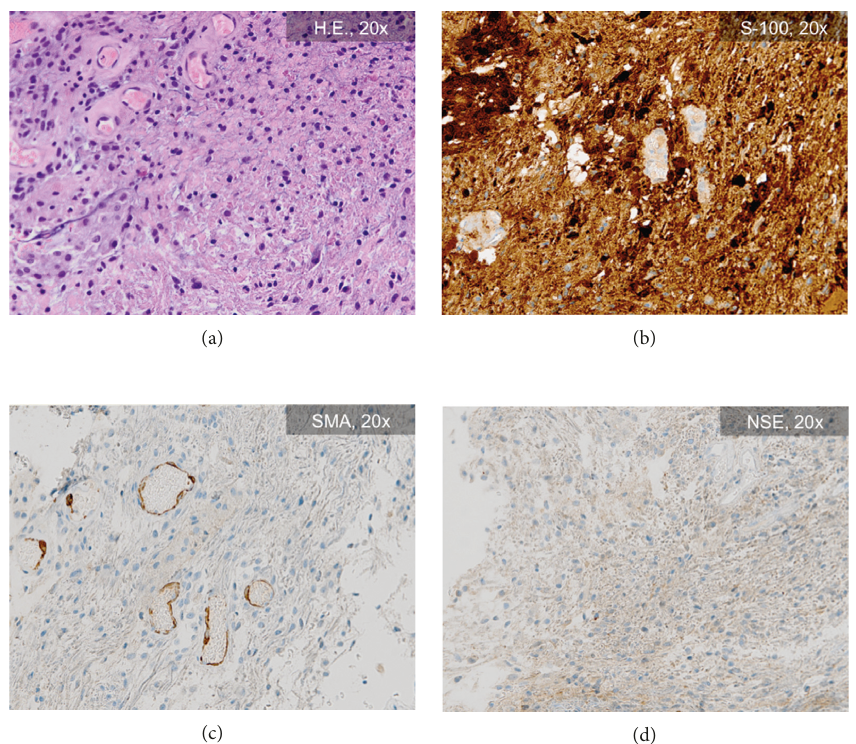
Figure 7: Images of histopathologic examination of the surgical specimen. (a) Hematoxylin-eosin staining represents a solid tumor with several cells showing a vortical pattern. (b) Tumor cells show intense S-100-specific immunoreaction. (c) The smooth muscular actin- (SMA-) specific immunoreaction is practically negative. (d) The neuron-specific enolase- (NSE-) specific immunoreaction represents a strong granular cytoplasmic